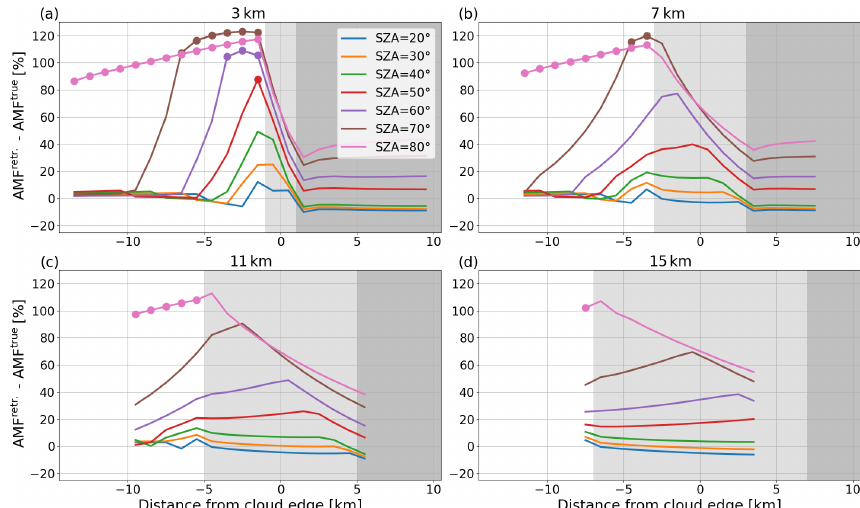
Figure 6. Liquid cloud NO 2 AMF retrieval bias for box-cloud simulations with spatial resolutions of (a) 3, (b) 7, (c) 11, and (d) 15km, as a function of the distance from the cloud edge for a variety of SZAs. The dark grey region is fully cloudy, the light grey region partly cloudy, and the white region fully clear. Dots represent conditions where the whole pixel is in the cloud shadow. The AMF uses the O 2 –O 2 cloud correction and is calculated with the polluted NO 2 profile.